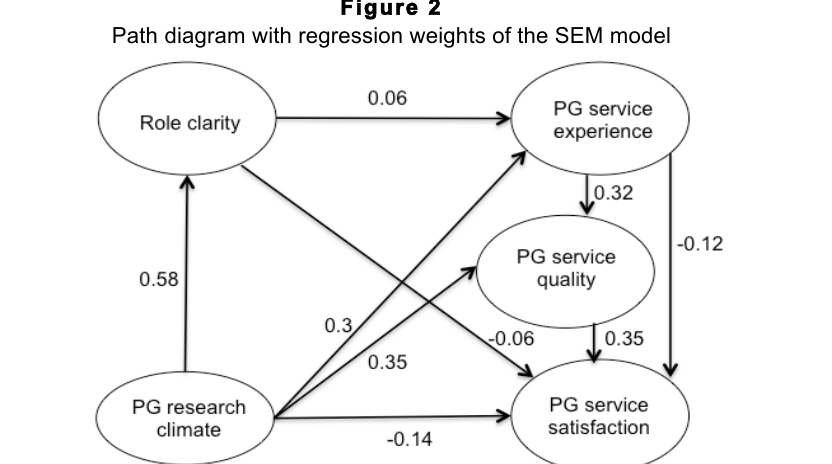
Path diagram with regression weights of the SEM